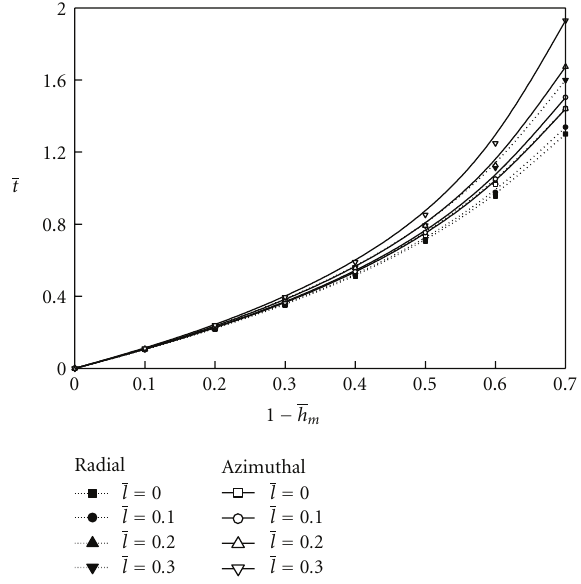
Figure 9: Variation of nondimensional mean load-carrying capac- ity W with M for di ff erent values of ψ with β = 0 . 05, l = 0 . 3 and c = 0 . 3.